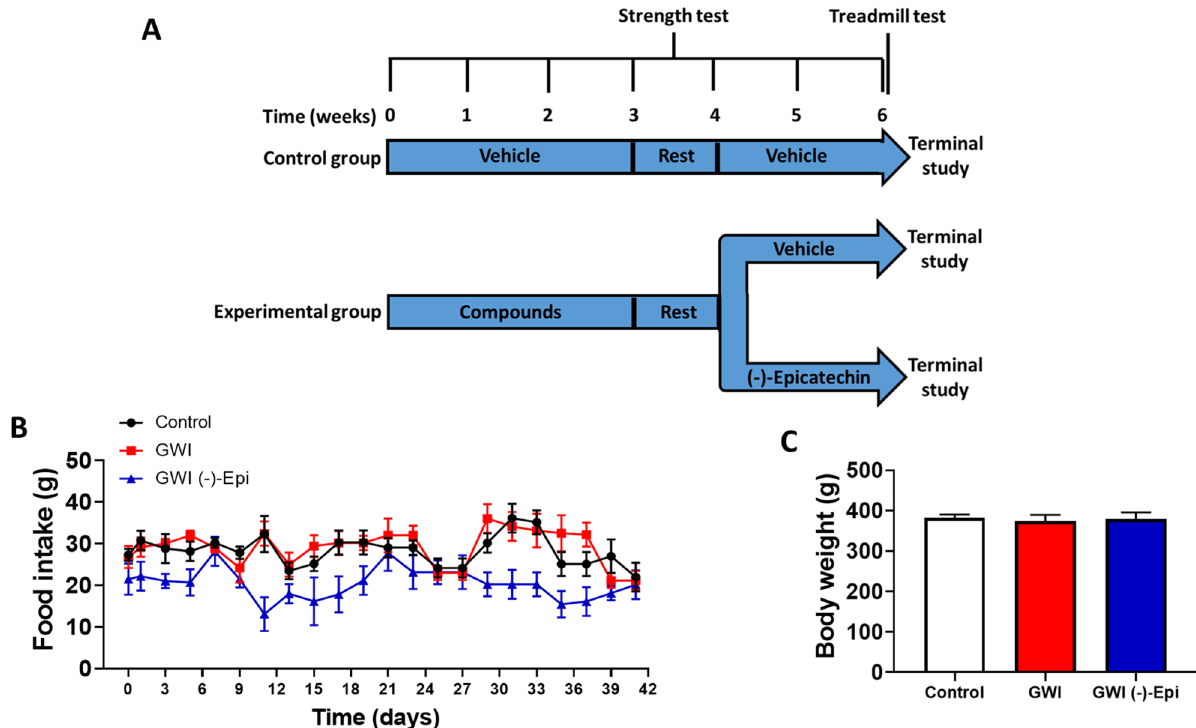
Figure 1. General experimental design describing period of time for controls and experimental groups (GWI and GWI (−)-Epi), and time points in which compounds or vehicle were administrated as well as strength and treadmill test were developed (A) . (B) Reports on the food intake during the total period of time of the study. (C) Reports on the body weight of the animal at the final study time